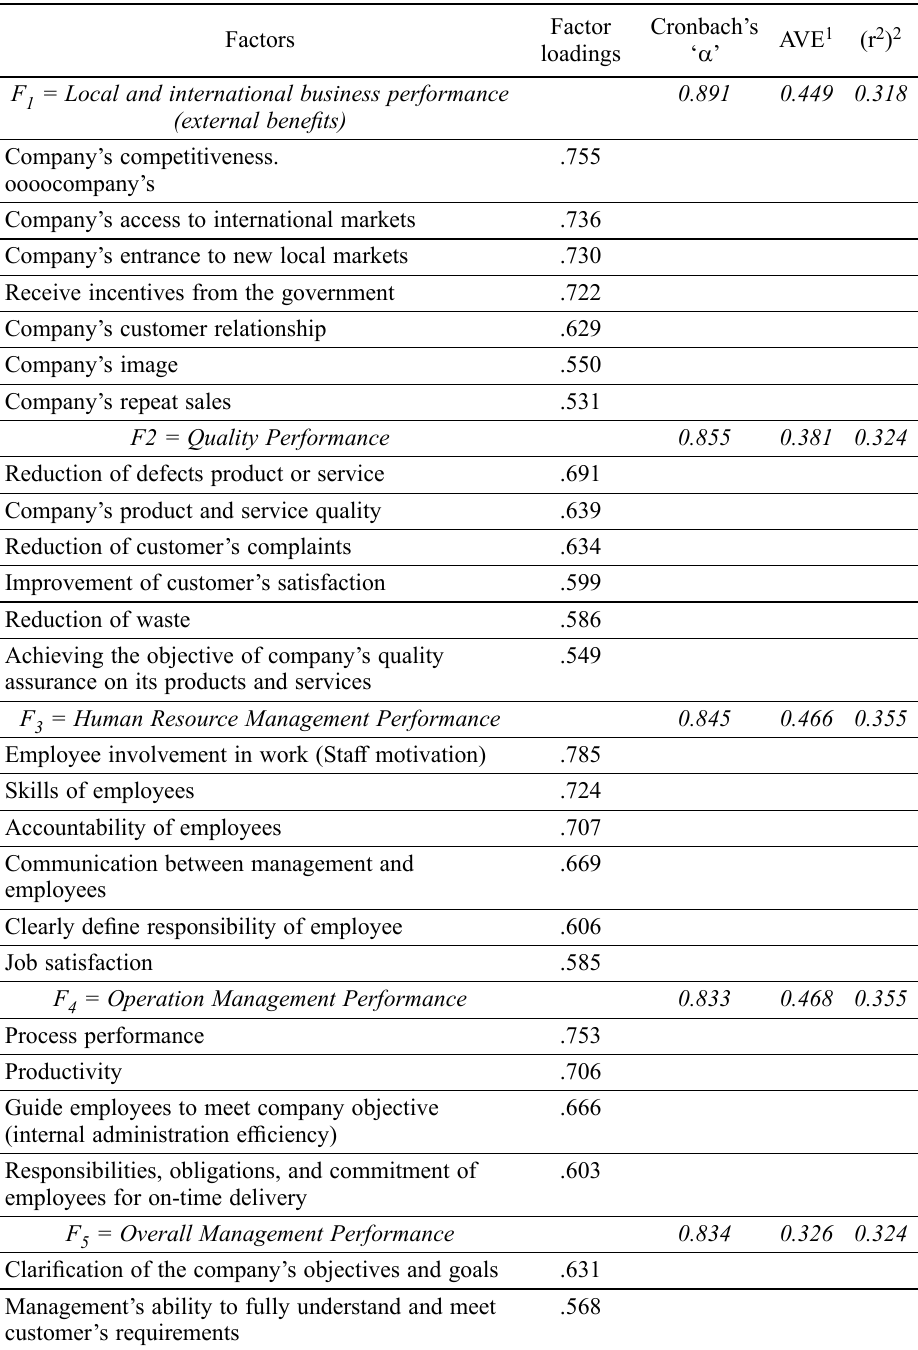
Table 1. Rotated factor matrix, reliability, and validity